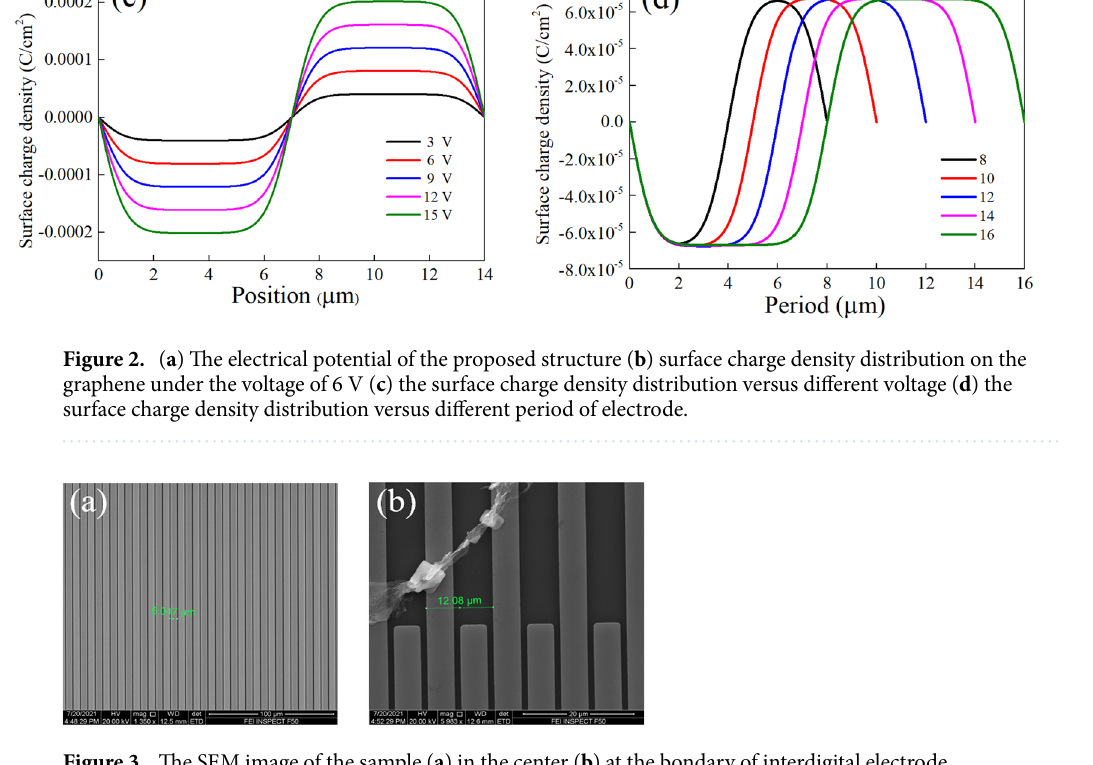
Figure 3. The SEM image of the sample ( a ) in the center ( b ) at the bondary of interdigital